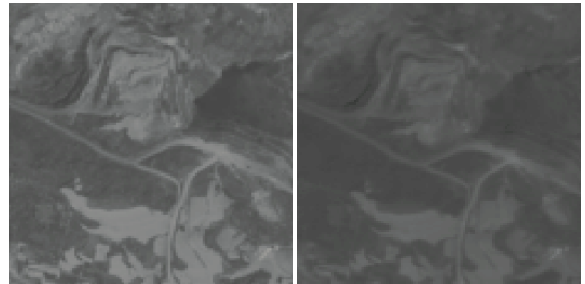
Figure 2. The panchromatic (left) and transformed multispectral (right) images of a same region. Both images are from the ZY-3 satellite where the nadir panchromatic sensor and multispectral sensor almost cover the identical spectrum. We transform the multispectral image with the average operation, but there still remains apparent systematic radiance